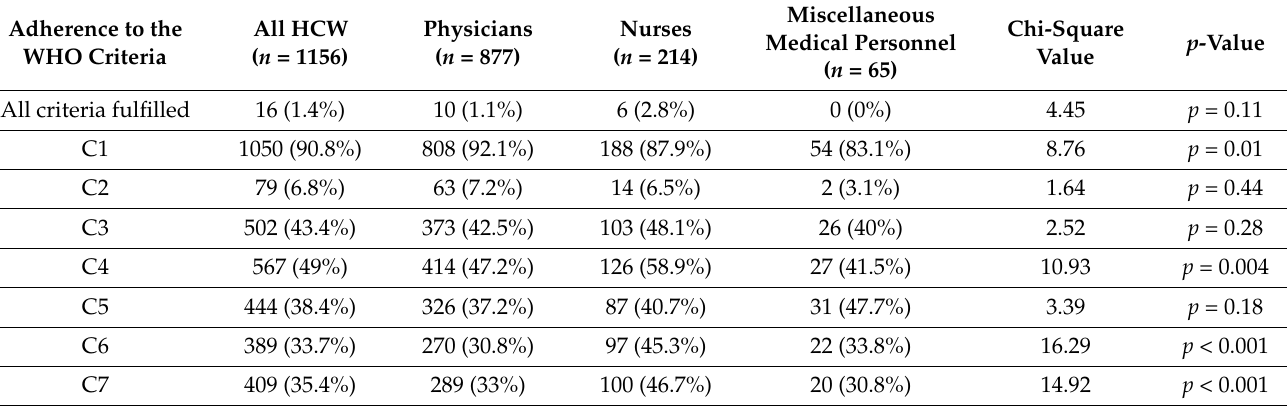
Table 2. Adherence to the WHO criteria among different medical professions.